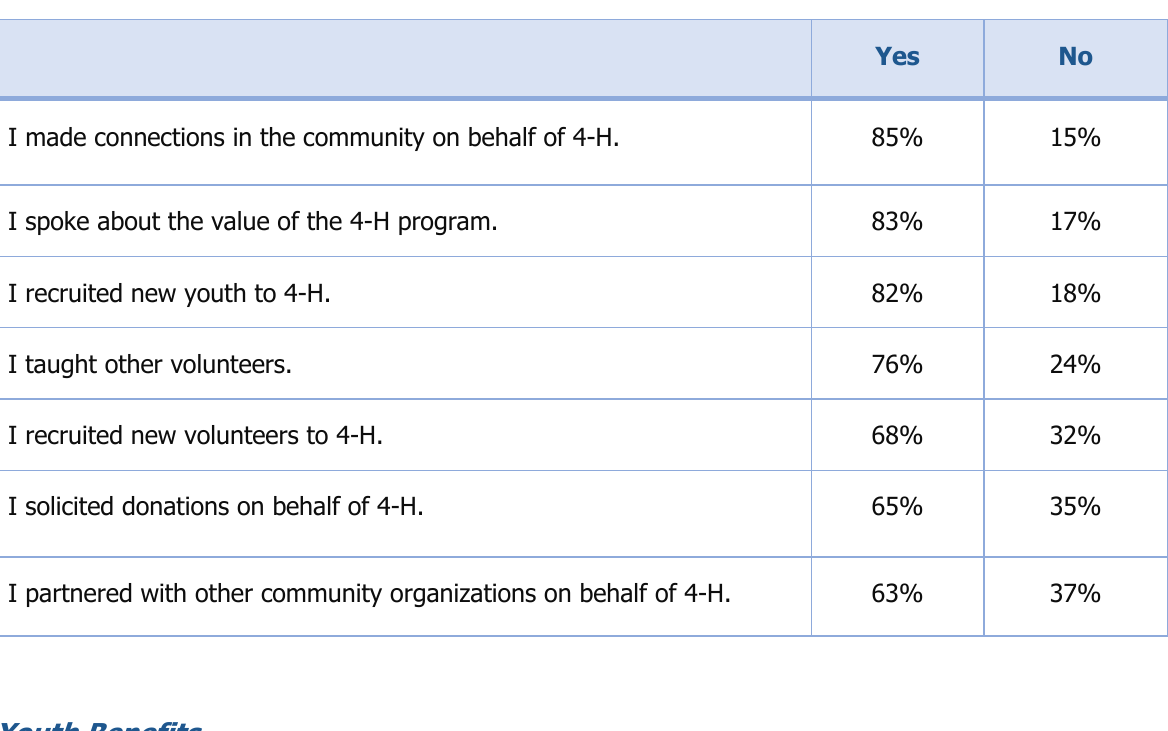
Table 4. Organizational